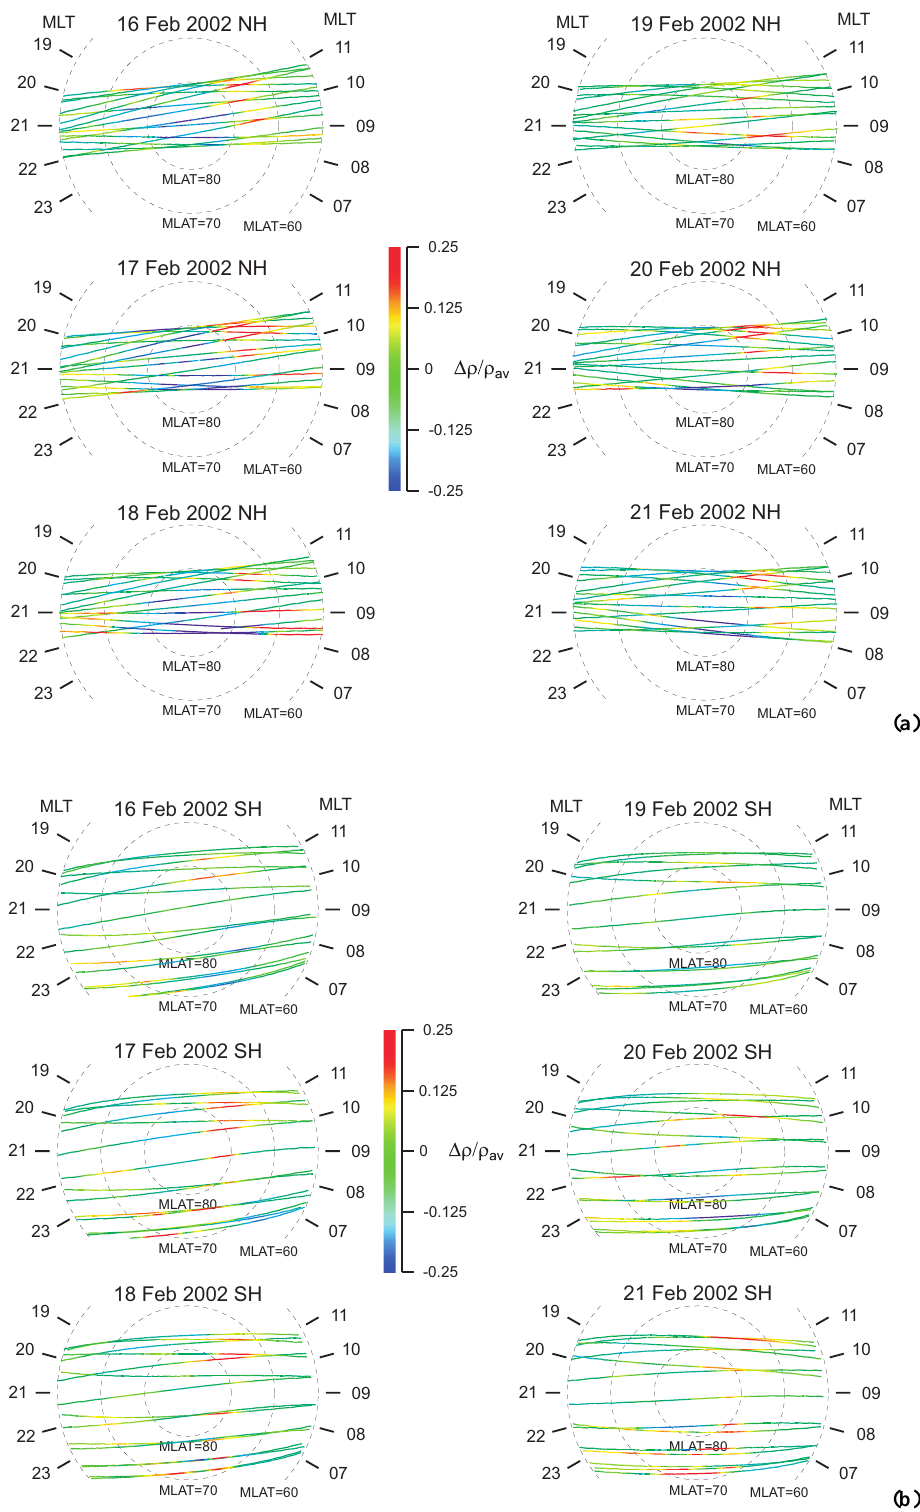
Fig. 6. (a) The relative density along the CHAMP trajectories in a magnetic latitude–magnetic local time frame for the days 16 to 21 Febru- ary 2002, Northern Hemisphere. The density along the tracks is colour coded according to the scale in the middle. (b) Same as Fig. 6a but for the Southern